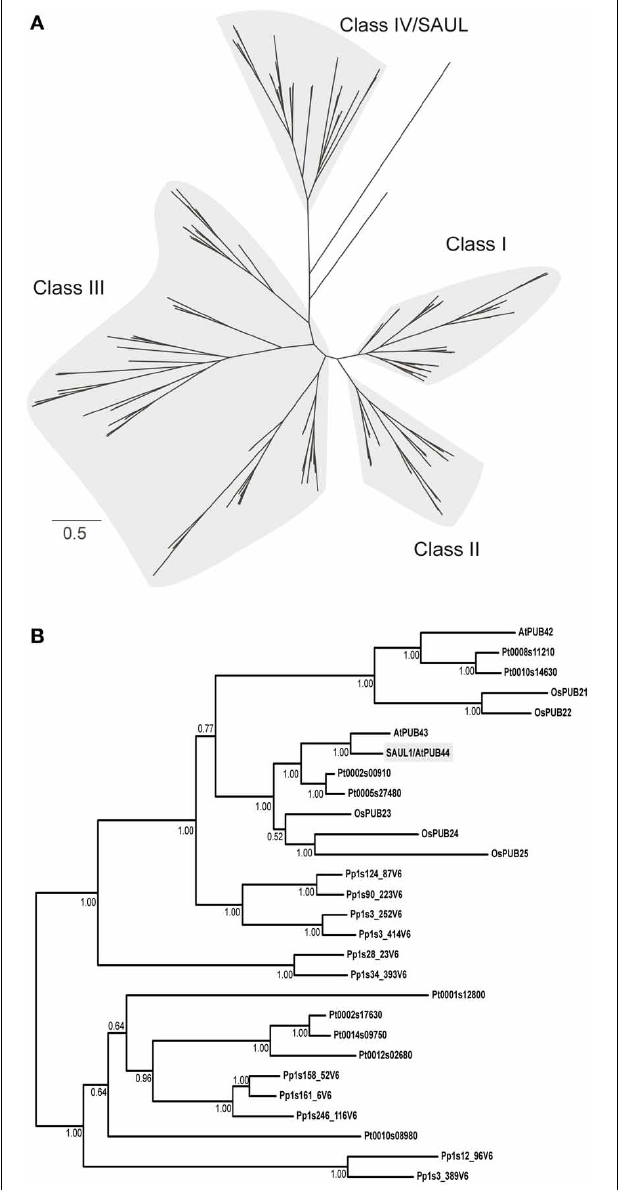
FIGURE 3 | Phylogenetic relationship of PUB-ARM proteins of Arabidopsis, rice, poplar and moss. (A) Simplified Bayesian phylogenetic tree depicting the relationship among class I–IV PUB-ARM proteins, as defined by Zeng et al. (2008). The bar represents 0.5 PAM distance. The tree derived from the analysis of the 2683 amino acid alignment; the full tree in Supporting Figure S2 . (B) Subtree of (A) depicting the relationship among class IV proteins, which include SAUL1-type proteins. Arabidopsis SAUL1 (AtPUB44) is highlighted in gray; the numbers at the nodes are Bayesian posterior probabilities.